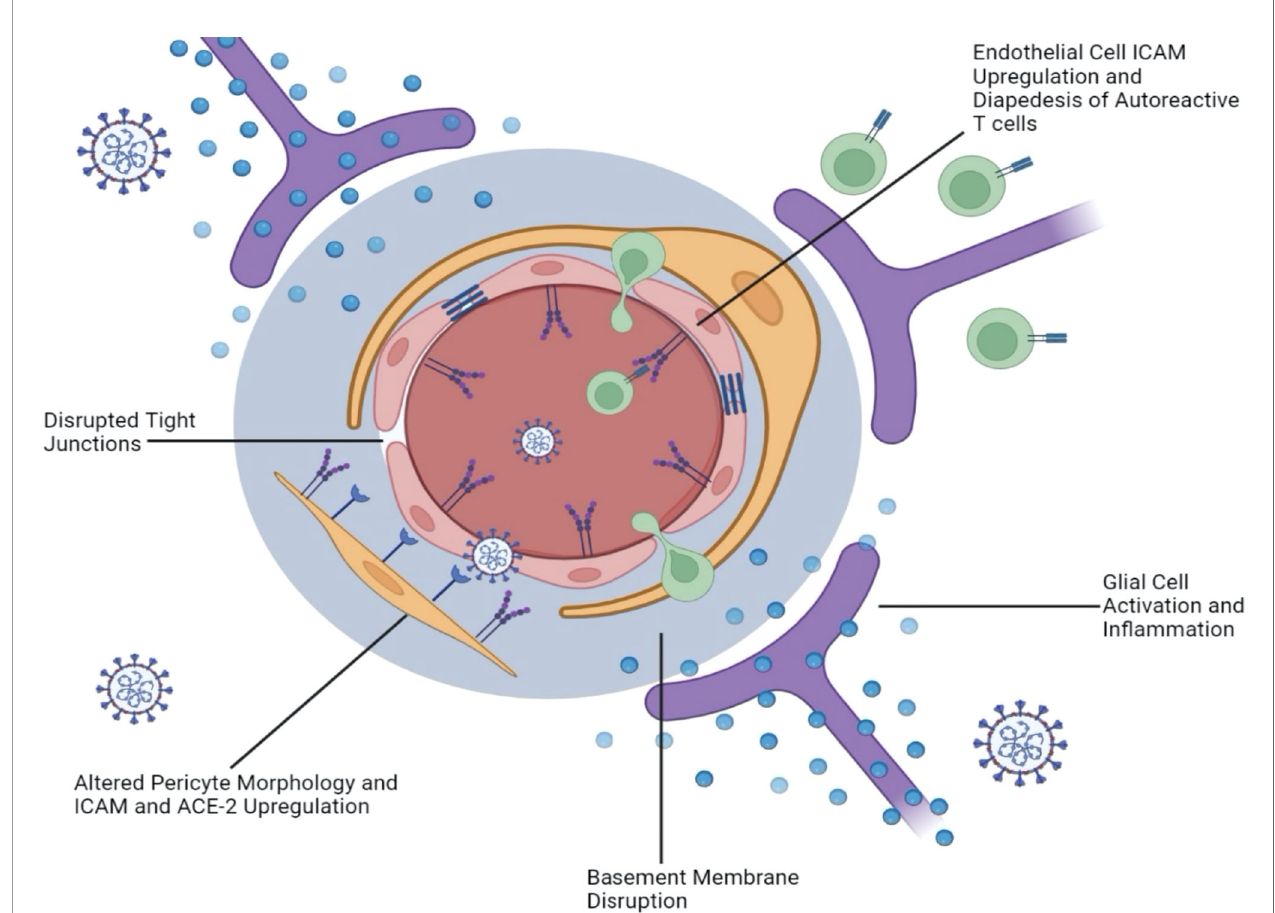
FIGURE 3 | SARS-CoV-2 Damages the Blood Brain Barrier from the “ Inside-Out ” as well as from the “ Outside-In. ” Neurotropic infection triggers the activation of glial cells and a proin fl ammatory response that damages the BBB from within the CNS (inside-out). This is supported by evidence of basement membrane disruption without tight junction alteration, as well as altered cerebral vasculature without direct endothelial cell infection. In contrast, evidence of disrupted or absent tight junctions, as well as upregulated ICAM and VCAM on endothelial cells suggests an outside-in mechanism that allows the diapedesis of autoreactive T cells from the blood, through the BBB, and into the brain. Contracted pericyte morphology coupled with upregulated ICAM and ACE-2 expression also suggests an outside-in